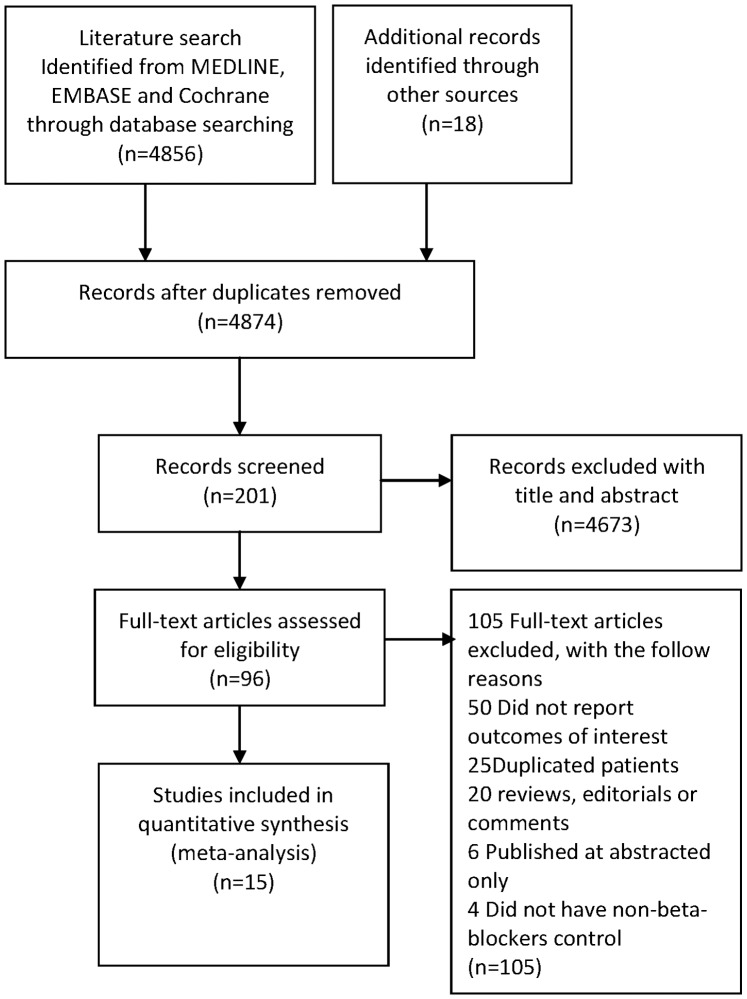
Study flow diagram in this meta-analysis.